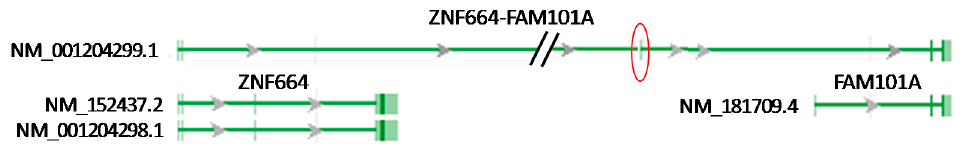
Figure 6. An image copied and modified from the NCBI showing that the ZNF664 - FAM101A RNA contains one exon (in the red circle) derived from the very-long intergenic region, making this RNA more likely to be produced via a transcriptional-readthrough mechanism but not via a trans -splicing of a ZNF664 transcript and a FAM101A transcript, although, theoretically, there may exist an unknown mechanism that can splice three transcripts (i.e., the ZNF664 , the intergenic, and the FAM101A transcripts) into one mature RNA.